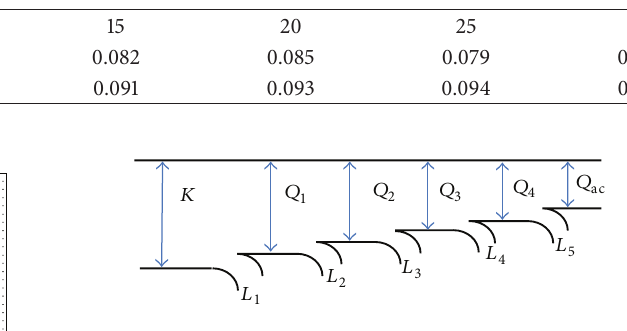
Figure 4: Productivity losses analysis for mathematical model of productivity with availability. 𝐾 = potential productivity (1/𝑡 𝑚 ) , 𝑄 1 = cyclic productivity (1/𝑡 𝑚 + 𝑡 𝑎 ) , 𝑄 2 = productivity of bottleneck machining time, 𝑄 3 = productivity of average level reliability for stations and mechanisms, 𝑄 4 = productivity and different level = actual productivity, 𝐿 1 reliability of stations and mechanisms, 𝑄 ac = productivity losses of auxiliary time, 𝐿 2 = productivity losses of bottleneck of machining time of stations, 𝐿 3 = productivity losses of average reliability of stations and mechanisms, 𝐿 4 = productivity losses of different reliability of stations and mechanisms, and 𝐿 5 = productivity losses of managerial problem and rejected/defected